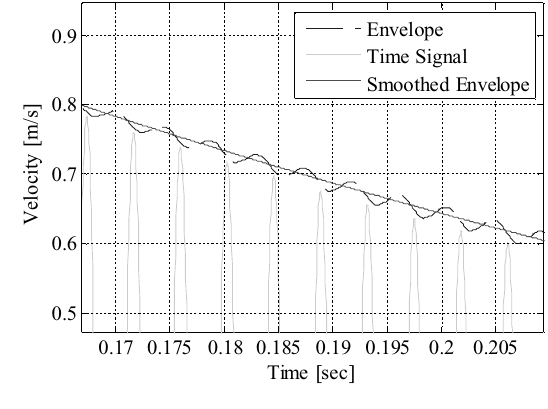
Fig. 14. Free decay of a bare beam.